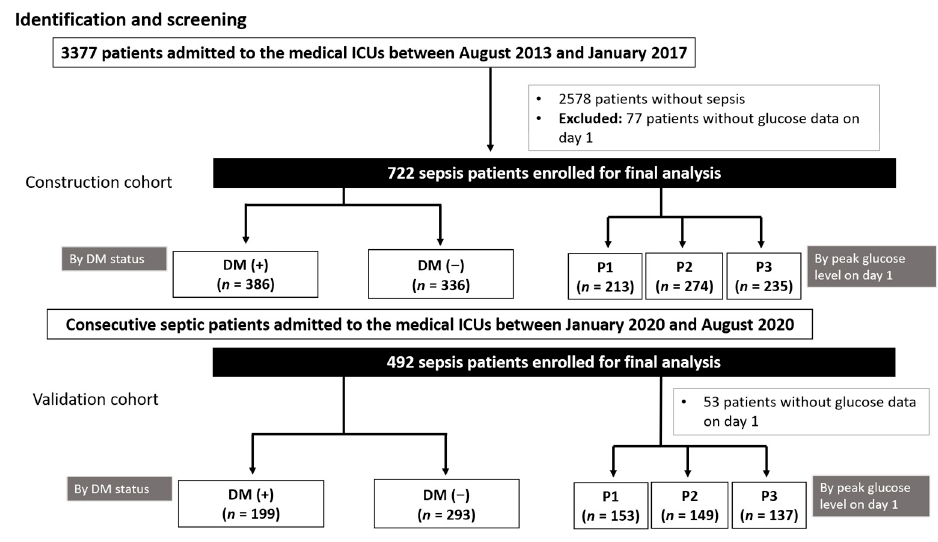
Figure 1. Study flowchart. Figure 1. Study Table 1. Baseline characteristics and outcomes of septic patients in construction cohort.